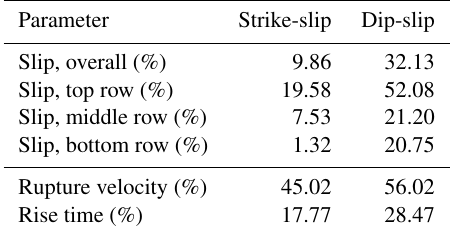
Table 1. Increase in information gain for 6C inversions compared to 3C inversions in percent. Subfaults are analyzed in the three hor- izontal layers (varying depth). The largest ratio of information gain increase for the slip amplitude between the 6C and the 3C inver- sion is in the deepest subfault layers. Rupture velocity and rise time benefit from rotation rate data for both types of scenarios, but the improvement is larger for the dip-slip